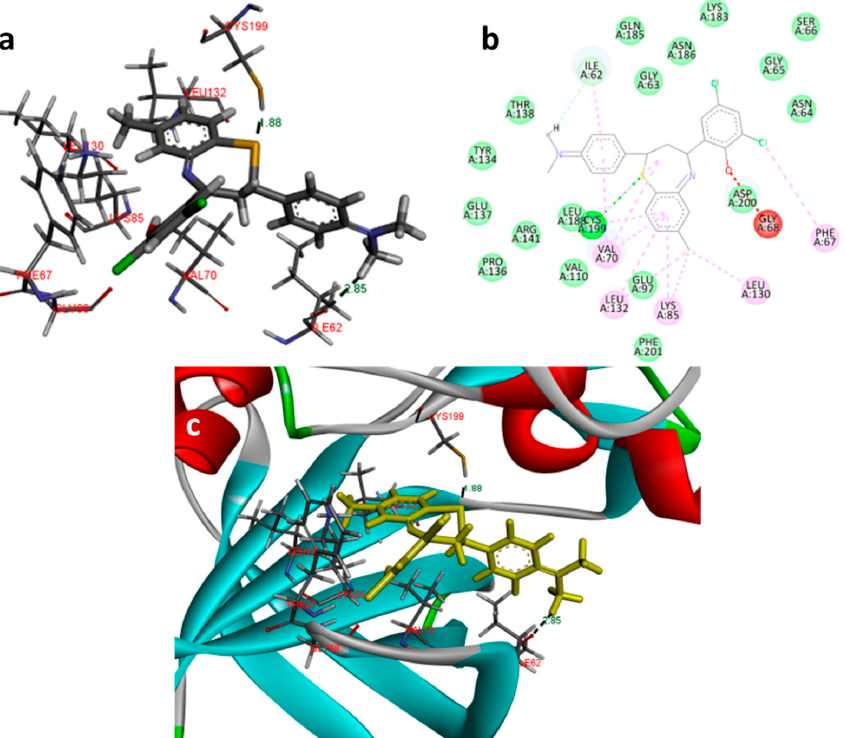
Figure 7. Docking images of 2f with 1Q41: ( a ) 3d representation of interactions; ( b ) 2D representation of interactions; ( c ) 3d orientation in the binding cavity of the protein.